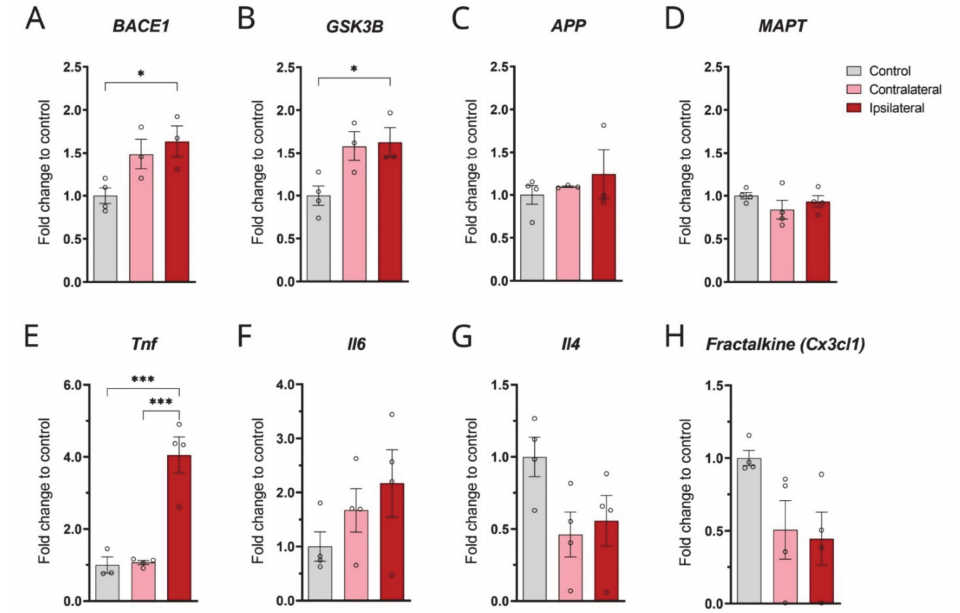
Figure 2. mRNAs levels of genes associated with AD and neuroinflammation are dysregulated in the cortex of the CCI rat model. mRNA expression analysis was carried out in rat CCI brains, comparing the ipsilateral and contralateral sides with naïve rat brains (n = 4 per group). ( A ) Quantification of BACE1 (one-way ANOVA F = 5.901 p = 0.0315); ( B ) GSK3 β (one-way ANOVA F = 6.138 p = 0.0289); ( C ) APP (one-way ANOVA F = 0.5521 p = 0.5989); ( D ) MAPT (one-way ANOVA F = 1.137 p = 0.3629); ( E ) Tnf (one-way ANOVA F = 27.65 p = 0.0003) ; ( F ) Il-6 (one-way ANOVA F = 1.648 p = 0.2455); ( G ) Il-4 (one-way ANOVA F = 3.366 p = 0.0810); ( H ) Cx3cl1 (Fractalkine) (one-way ANOVA F = 3.620 p = 0.0702) mRNAs. Values shown in graphs represent the mean value ± SEM and are expressed as fold change of naïve control rats. Statistical analysis included one-way ANOVA (Tukey’s multiple comparisons test) * p < 0.05, and *** p <